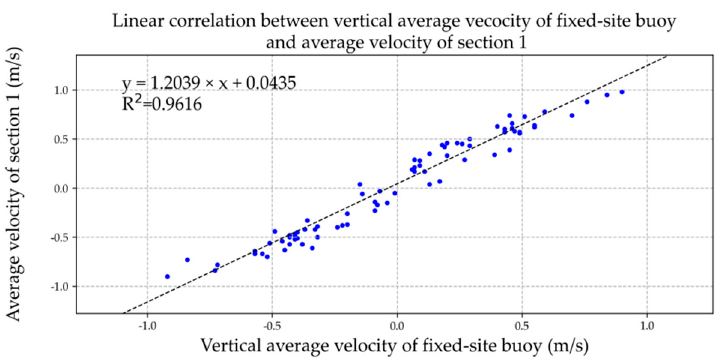
Figure 11. Linear correlation between vertical average current of fixed ‐ site buoy and average velocity of section 1. The data of blue dots represent the relationship between vertical average velocity of the fixed ‐ site buoy(x) and average velocity of section 1(y).